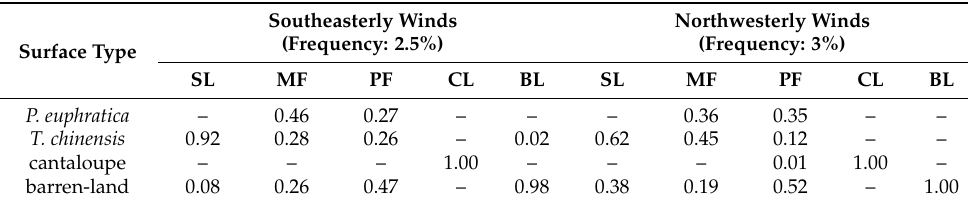
Table 3. Relative weight of each surface types in the flux footprint of each EC site for two prevailing wind